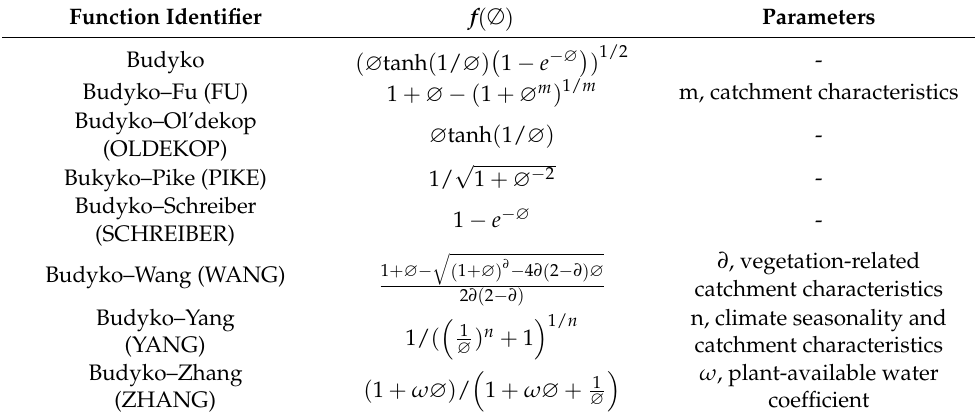
Table 2. Budyko-type